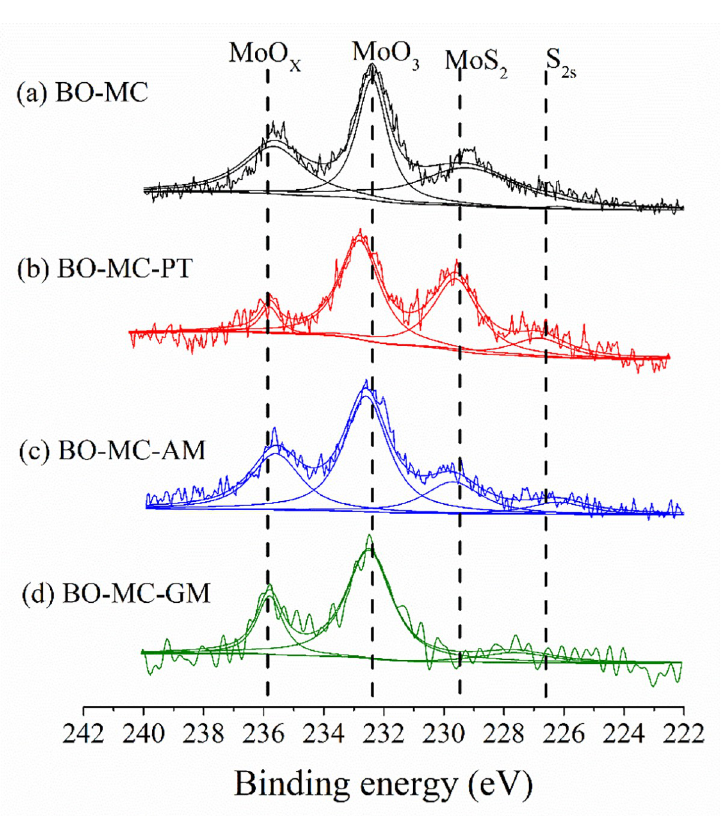
Fig 12. Friction surface XPS photopeaks of Mo3d lubricated with MoDTC (MC) containing lubricants.